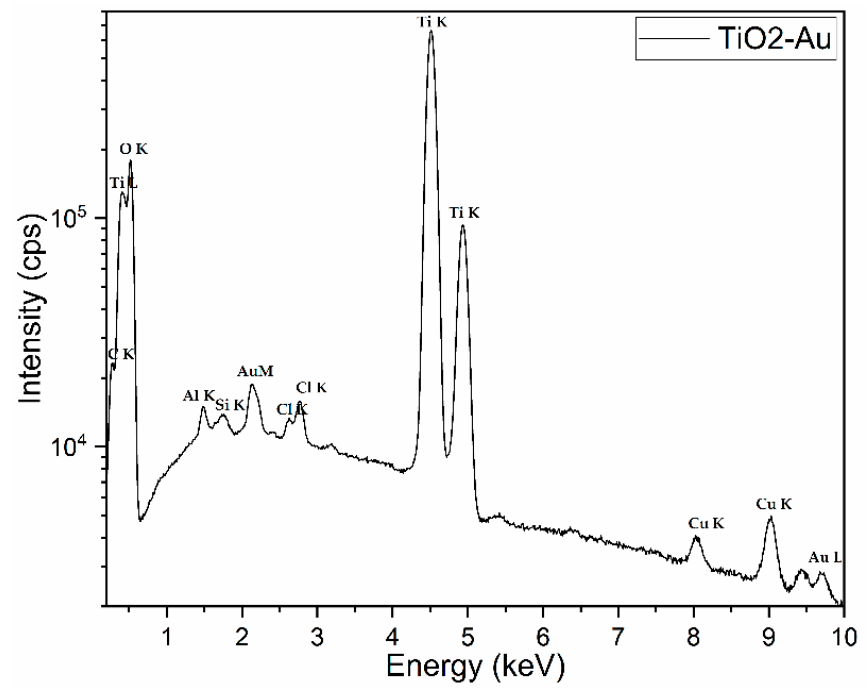
Figure 8. EDX spectrum of the synthesised material.